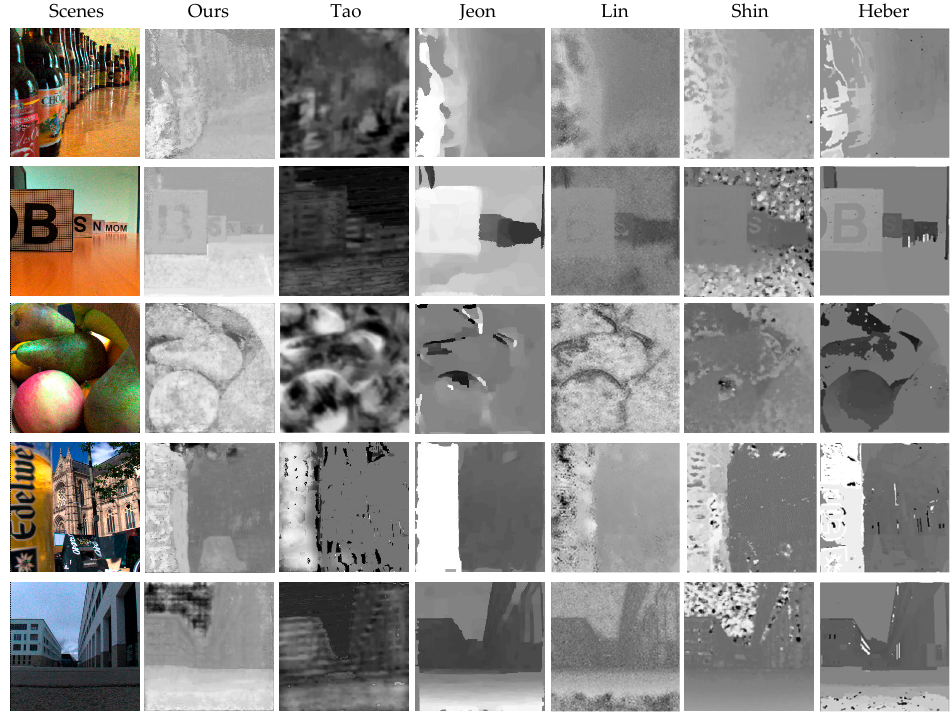
Figure 7. Examples of depth estimation results for each method in the real light field.